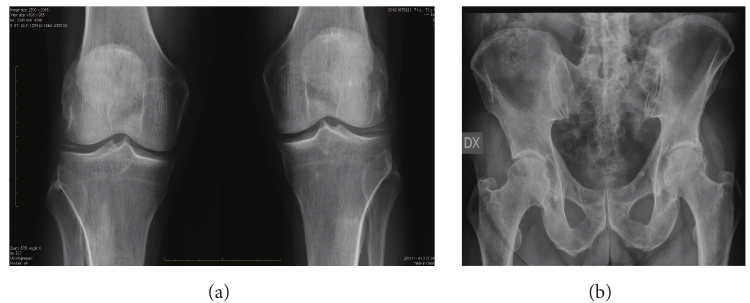
Figure 1: Conventional X-ray of knees (a) and hips (b). The figure shows a picture of osteoarthritis associated with calcifications in menisci (a) and in the soft tissues near the hip bilaterally